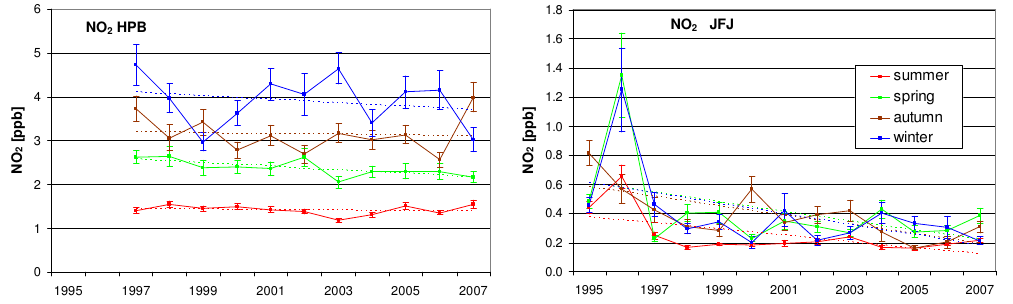
Fig. 14. NO 2 time series since 1995 for the different seasons at the respective “DACH” sites; blue: winter; red: summer, brown: autumn, green: spring, yearly mean mixing ratios (solid) with standard error of the mean and linear trend (dashed).